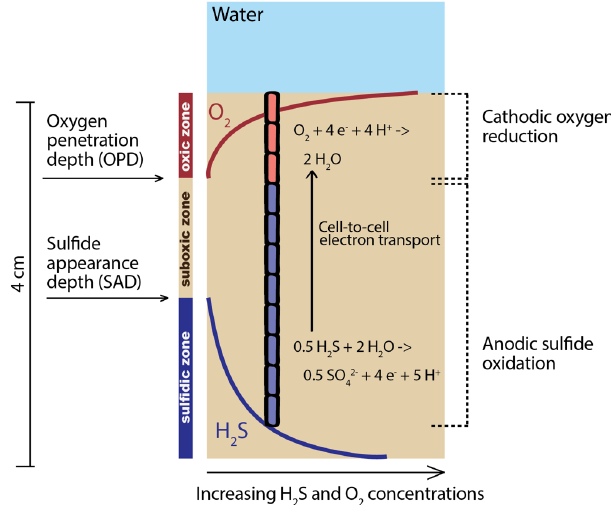
Figure 1. Schematic illustration of the metabolism of a cable bac- terium. Electrogenic sulfur oxidation involves two spatially sepa- rated redox half reactions, which are referred to as the cathodic oxy- gen reduction and the anodic sulfide oxidation. The redox coupling is ensured by an electron transport axis through the cable bacteria filament. The metabolism of cable bacteria leads to three distinct geochemical zones in the sediment: the oxic zone delineated by the sediment–water interface and the oxygen penetration depth (OPD); the suboxic zone defined as the sediment zone, where neither O 2 nor H 2 S is detectable, and the sulfidic zone, where free sulfide ac- cumulates below the sulfide appearance depth